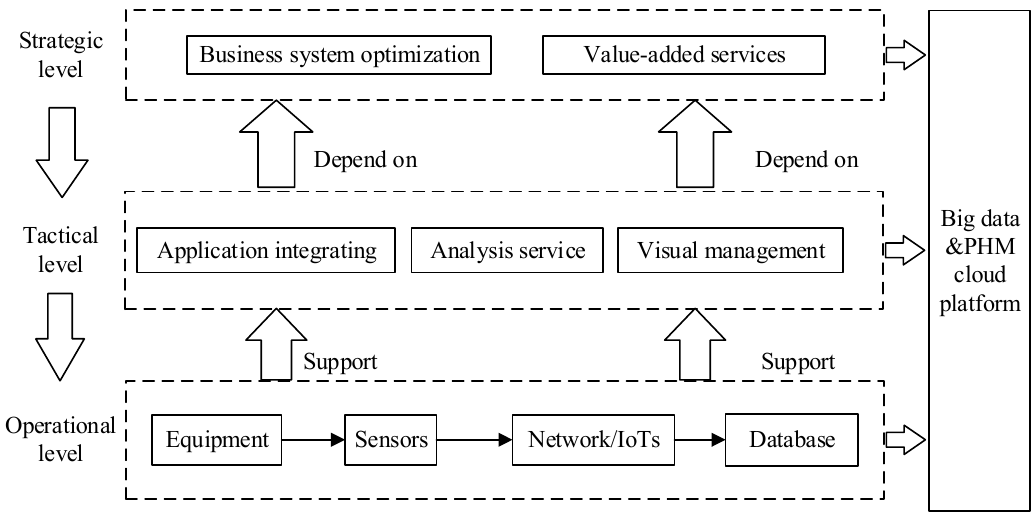
Figure 1. Integrative Prognostics and Health Management framework base on CNN and IoTs.